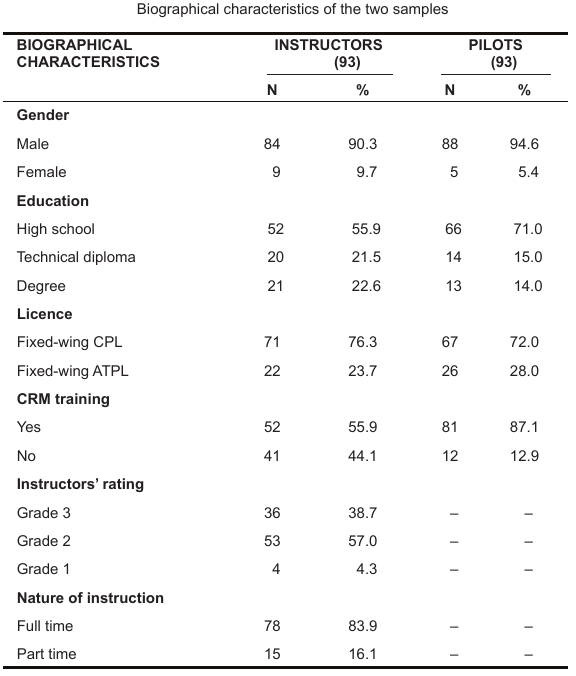
TABLE 1 Biographical characteristics of the two samples